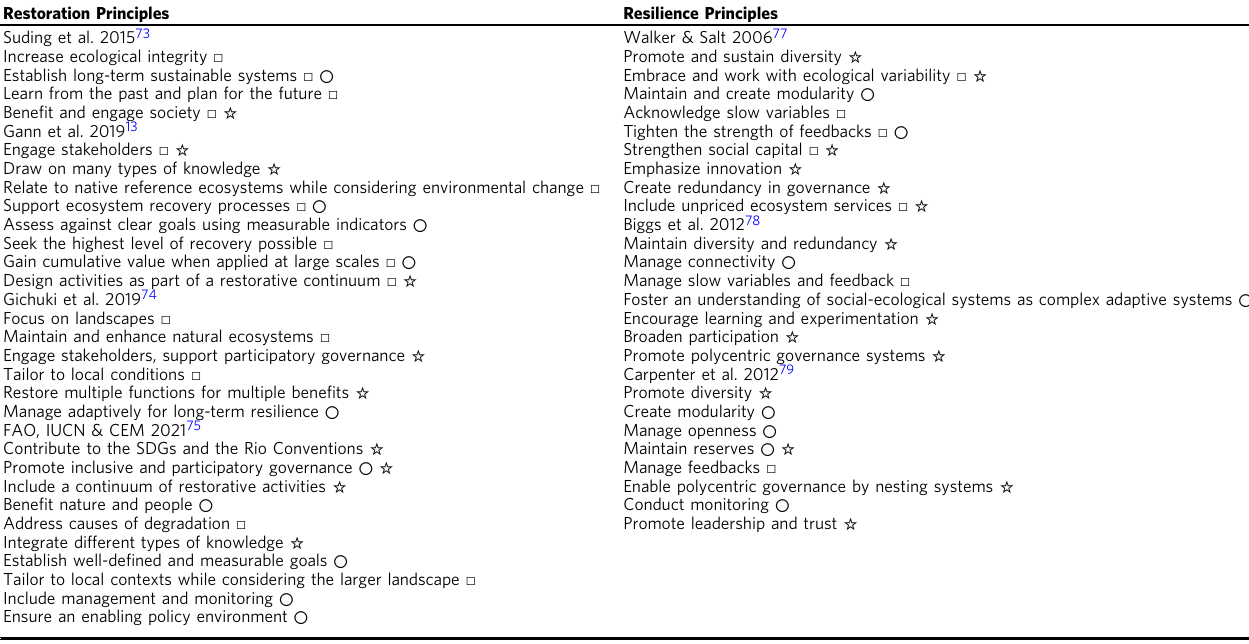
Table 1 Principles put forward by different sources to support successful ecosystem restoration and enhance